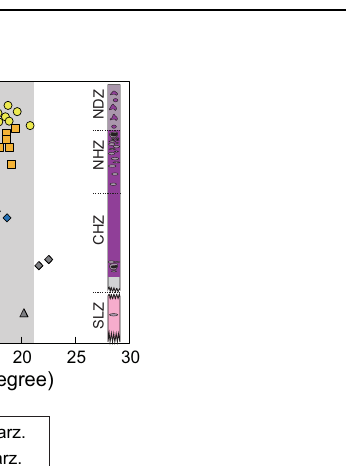
1300°C, 1350°C, 1400°C, and 1450°C. The color-coded pressure-decreasing gradient is of 0.1 kbar, and the white circles mark the pressure steps of 0, 0.5, 1.0, 1.5, 2.0, 2.5, 3.0, 3.5, and 4.0GPa. The detailed melting conditions were listed in Supplementary Dataset 10. Small gray circles represent global abyssal peridotites without those veined by gabbro, pyroxenite, and dunite 13 – 15 ; light-blue circles representthepreviouslyreportedharzburgitesandlherzoliteswithunclearspatial contexts from the Luobusa ophiolite 20,32,35,38 .